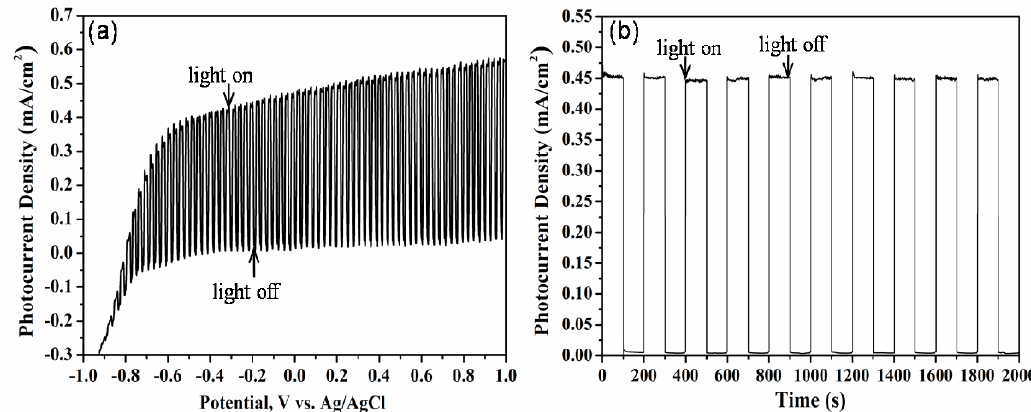
Figure 5. Photoelectrochemical water splitting behavior of Ti-Ni-Si-O nanostructures: ( a ) I - V curves in dark and under illumination; ( b ) transient photocurrent responses.